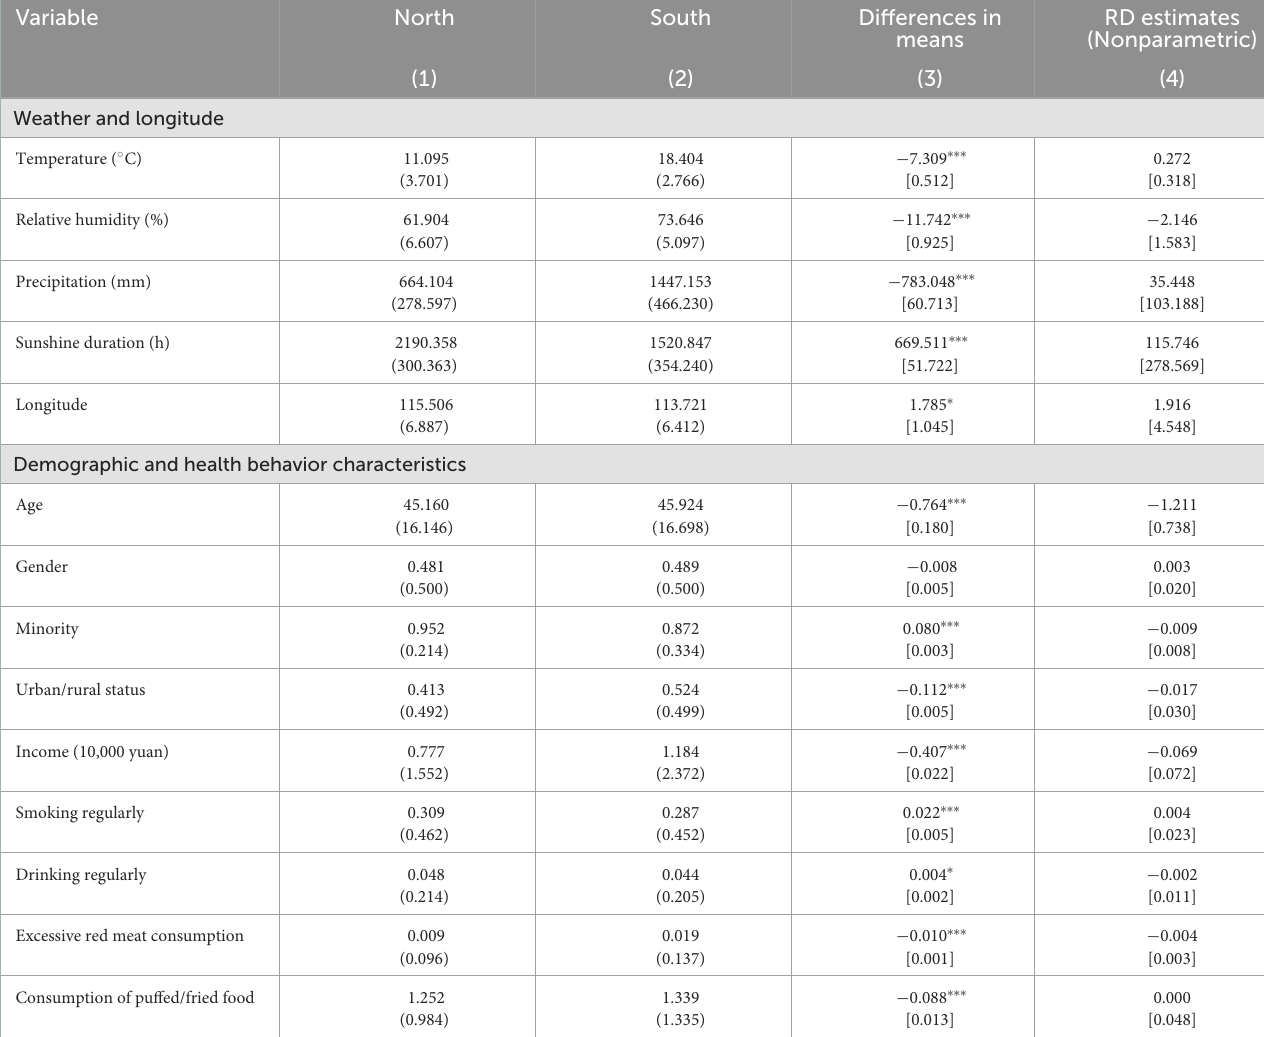
TABLE 1 Summary statistics of observables for the north and south of the Huai